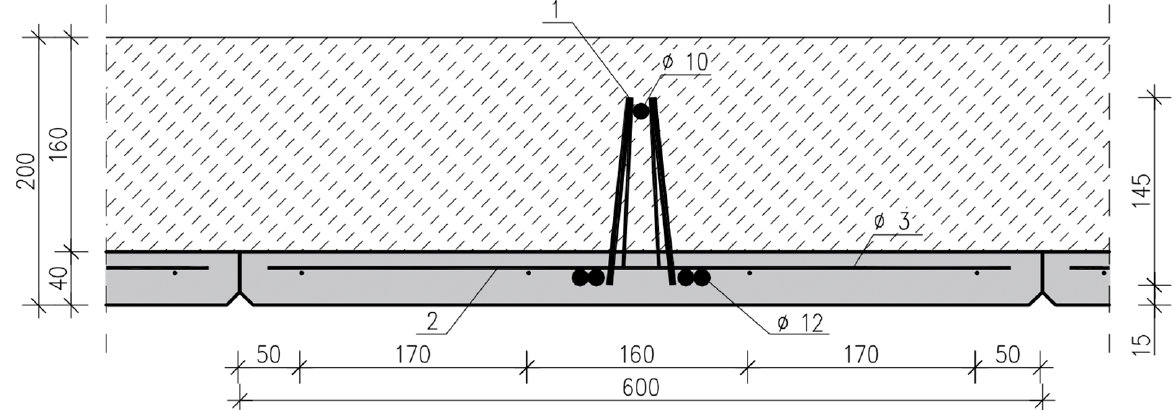
Figure 5. Cross-section of the slab with LGR panels: 1—lattice girder and 2—secondary reinforcement.